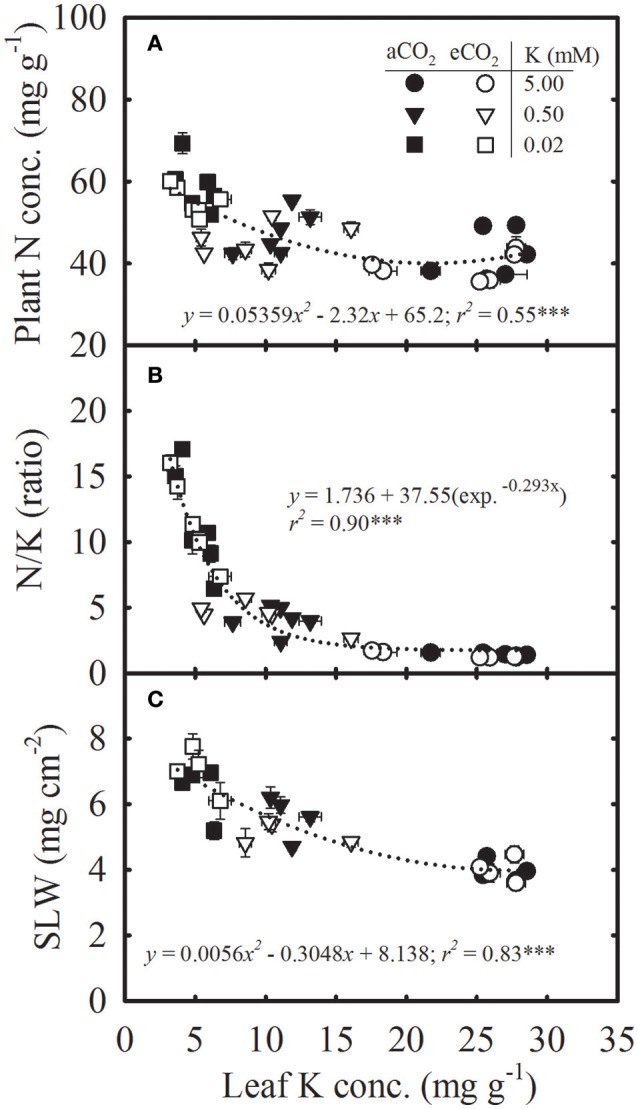
Relationship of leaf potassium (K) concentration with (A) plant nitrogen (N) concentration, (B) N/K ratio, and (C) specific leaf weight (SLW) of soybean grown under ambient (aCO2; filled symbols, 400 μmol mol−1) and elevated CO2 (eCO2; open symbols, 800 μmol mol−1) at three K levels. Symbols represent the mean ± SE of six individuals measured across the repeated experiment. Data are pooled from the destructive harvests at 28, 42, and 112 (A,B) or 28 and 42 (C) days after planting. Dotted lines represent either the polynomial second-order (A,C) or exponential decay (B) equation fitted across CO2 treatments. The significance level of the regression analysis for each equation is indicated as *** representing P ≤ 0.001. Error bars smaller than the symbols are not visible.